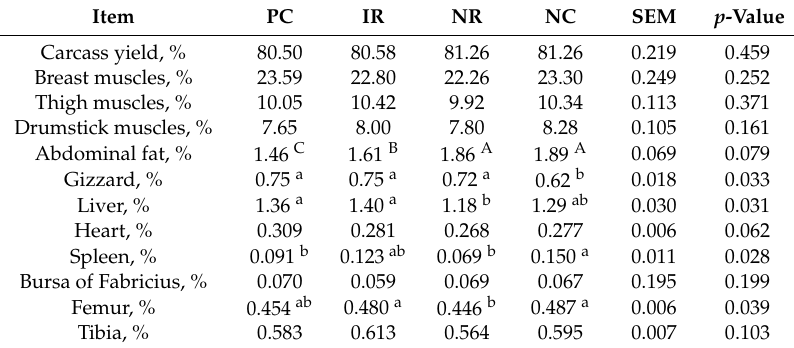
Table 3. Results of turkey carcass analysis and relative weights of selected organs and bones (body weight =